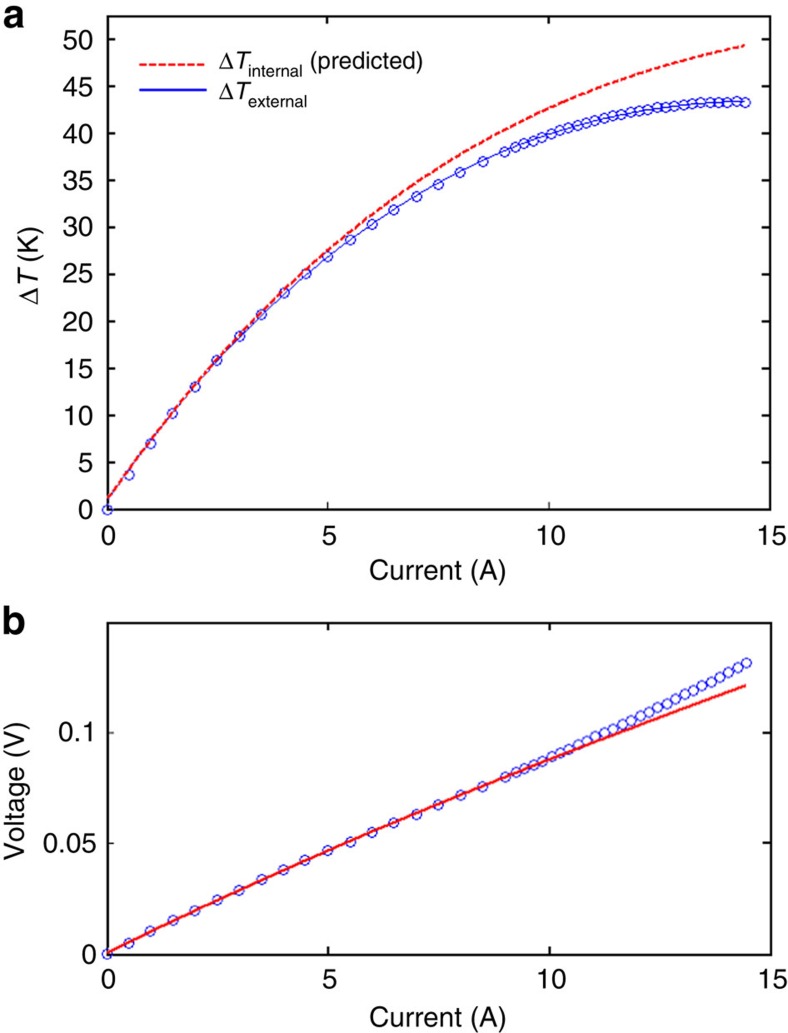
Analysis of experimental data.(a) Experimental ΔT versus I data for the module with the largest effective contact diameter (230 μm) and the fit of equation 4 to the data. Blue dots represent experimentally measured data points, and the blue line represents the fit . The red dotted line indicates predicted internal temperature difference (Thint−TC) versus I. (b) Corresponding V versus I data for the same module. The blue dots represent experimentally measured data points, and the red line represents the theoretical fit.